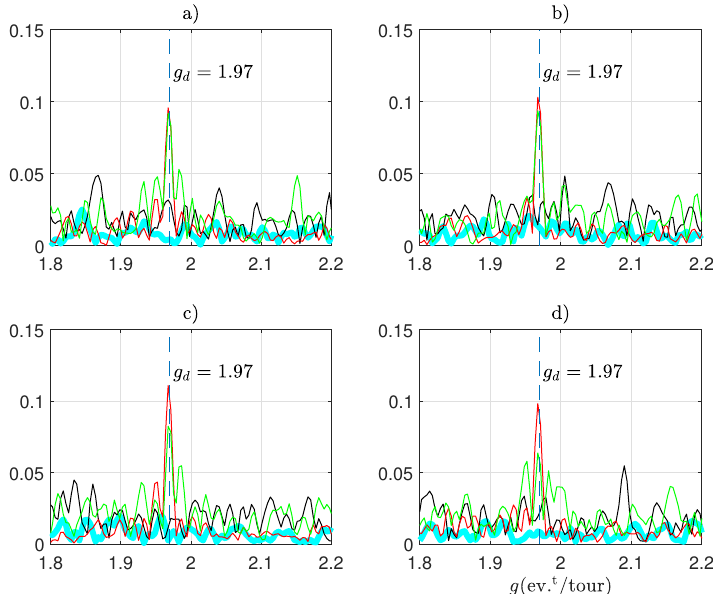
Figure 12. Comparison for different records. ( a ) to ( d ) respectively records 2 to